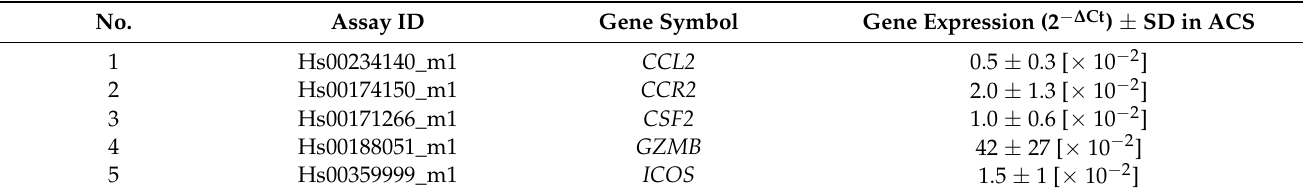
Table 2. The mRNA expression of pro-inflammatory molecules exclusively presented in ACS patients.